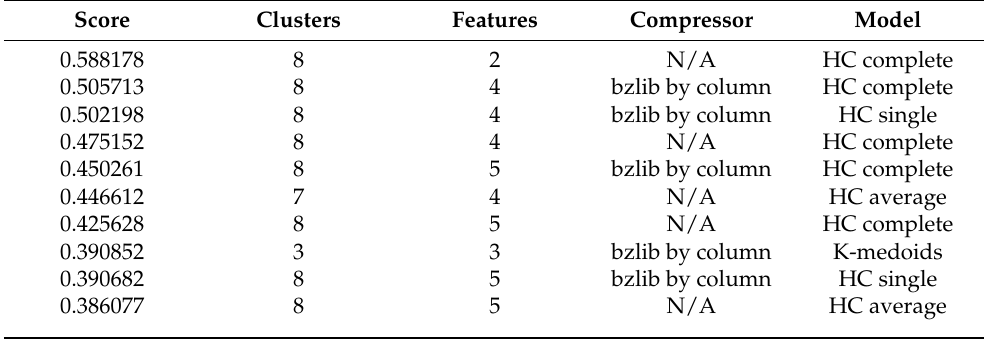
Table 8. V-measures of the best five clustering by compression and the best five standard compression models for the Golimumab dataset. N/A means that no compressor was applied.